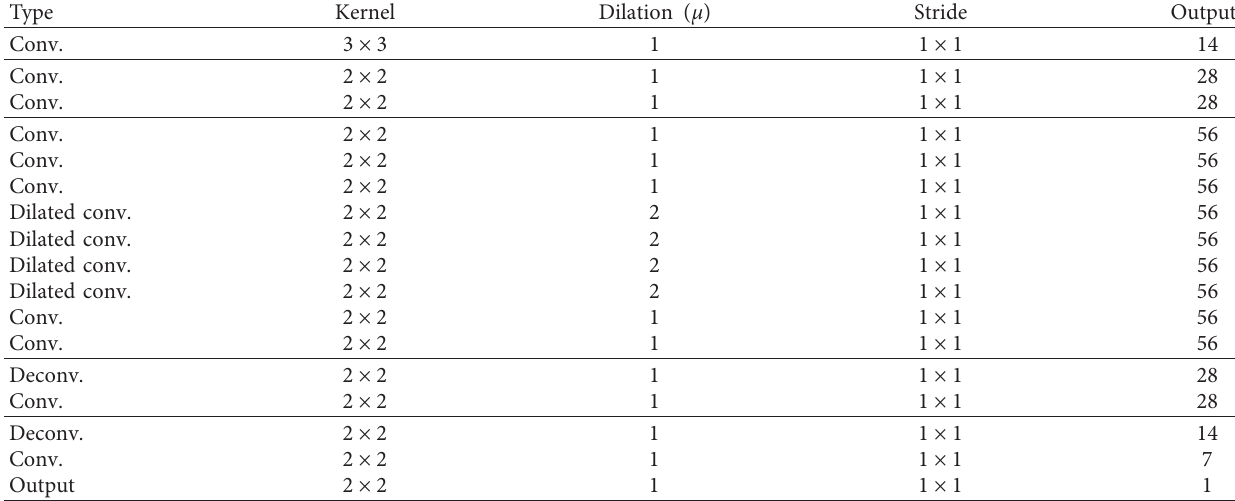
Table 3: Architecture of base neural network.